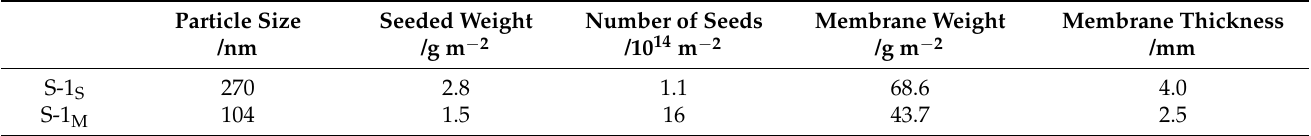
Table 1. Seeding and membrane features of silicalite-1